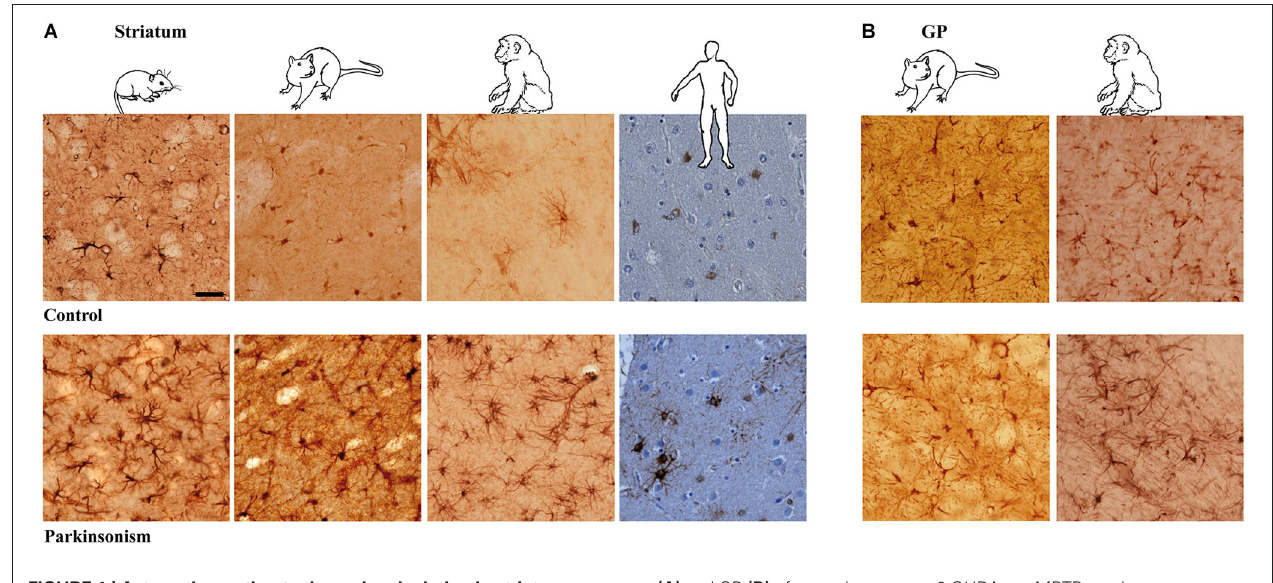
FIGURE 1 | Astrocytic reaction to dopamine depletion in striatum and GP of animal models of PD and parkinsonian patients . Dopamine depletion increase GFAP-S100 β immunolabeing in striatum